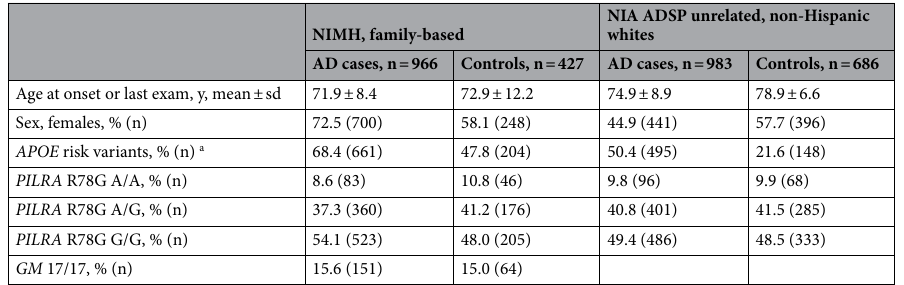
NIMH, family-based AD cases, n = 966 Controls, n = 427 AD cases, n = 983 Controls, n = 686